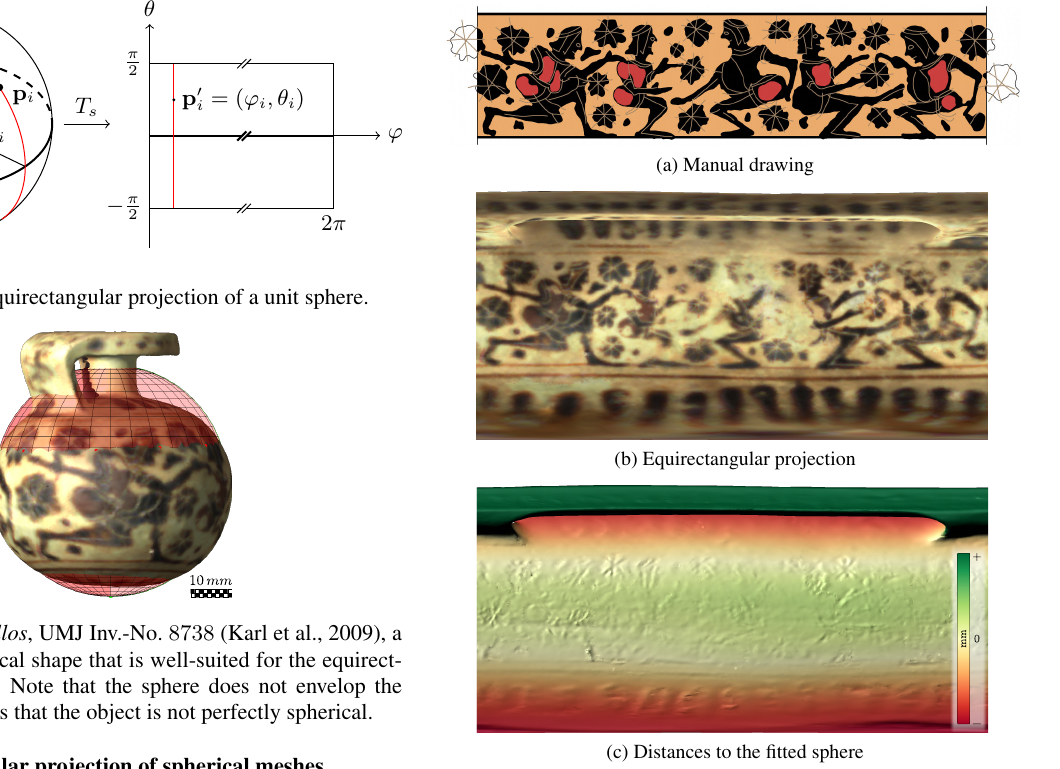
Figure 8: A comparison of a manual drawing (courtesy of S. Karl) and the equirectangular projection for the aryballos in Fig.